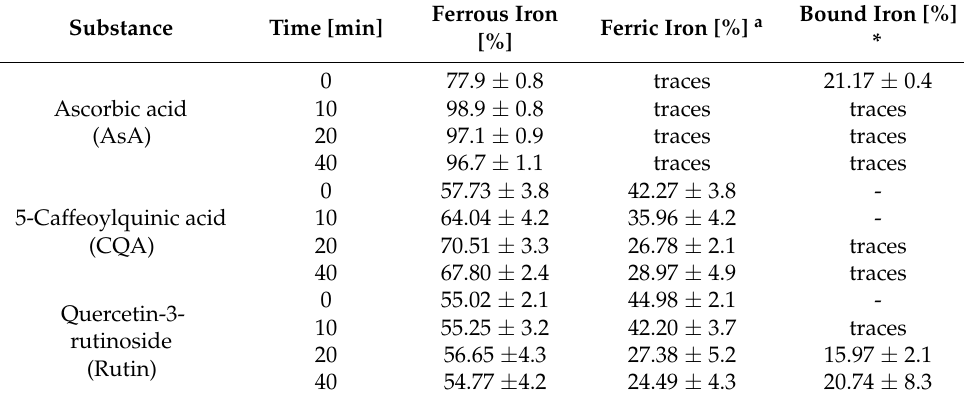
Table 1. Measured ionic iron species, ferric iron (Fe 3+ ) and ferrous iron (Fe 2+ ), and calculated bound iron after mixing with ascorbic acid, 5-caffeoylquinic acid, and quercetin-3-rutinoside, and cooking for 0, 10, 20, and 40 min with equimolar concentrations of ferrous and ferric iron in percent; traces ≤ 5%.